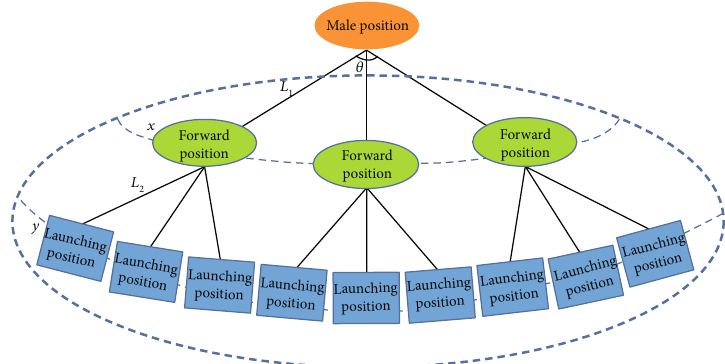
Figure 1: Position deployment pattern